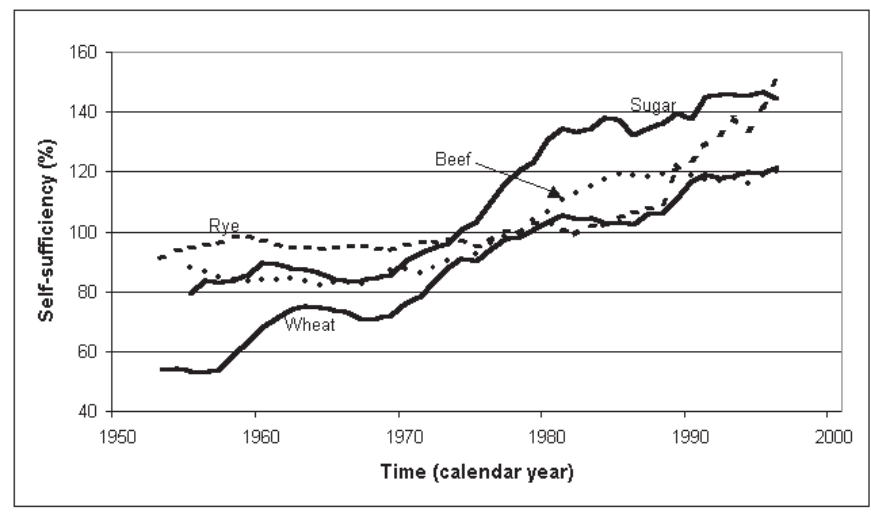
FIGURE 3. Postwar German self-sufficiency for wheat, rye, beef, and